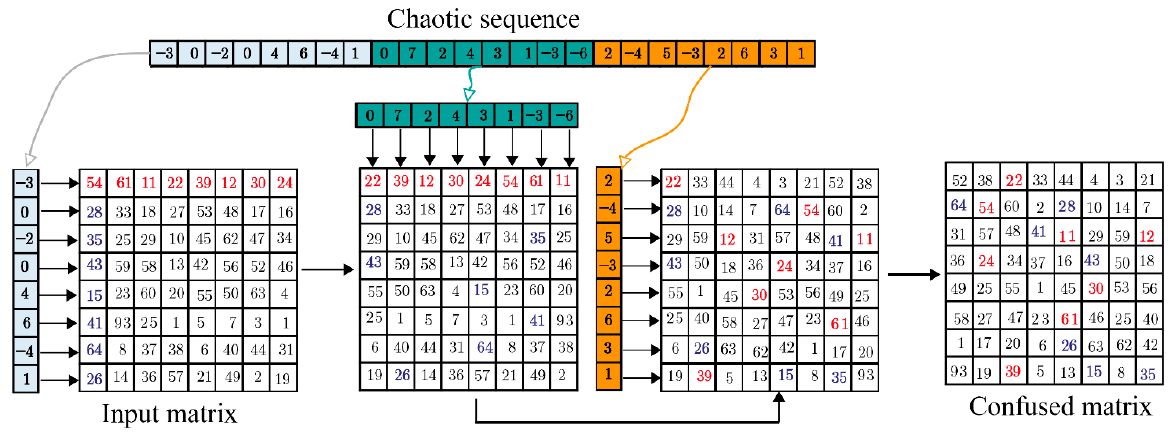
× Figure 11. Confusion process of 8 8 matrix rows and columns using a chaotic sequence. Figure 11. Confusion process of 8 × 8 matrix rows and columns using a chaotic